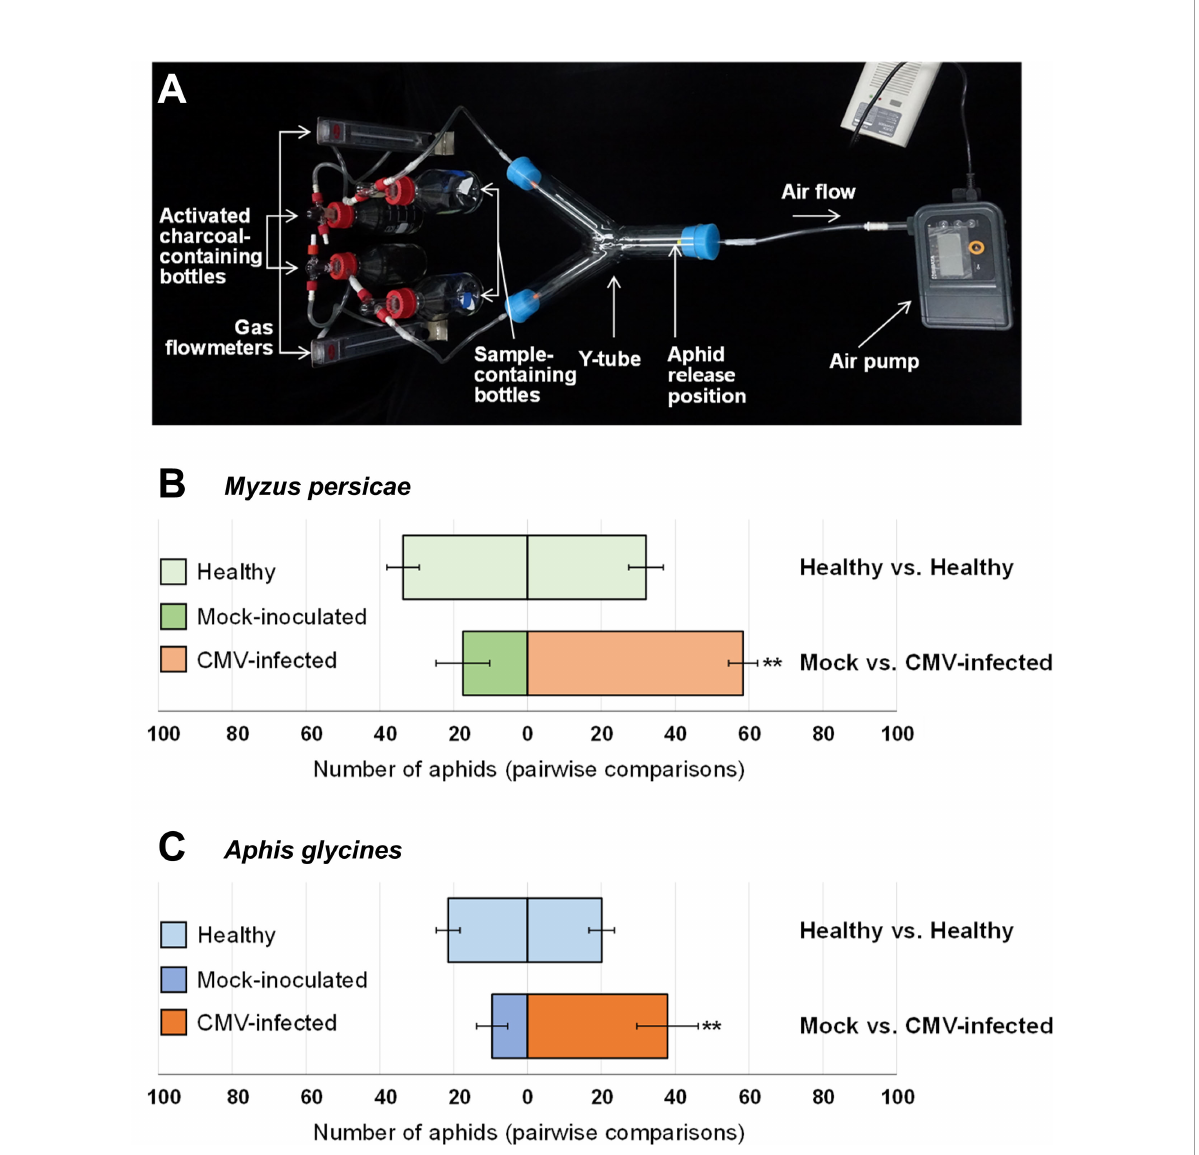
FIGURE 1 Aphid attraction to volatiles from healthy, mock-inoculated, or cucumber mosaic virus (CMV)-infected plants. (A) The glass Y-tube olfactometer used in this study for aphid preference tests. Pairwise preference tests for Myzus persicae (a species that colonizes pepper) (B) and Aphis glycines (a species that does not colonizes pepper) (C) . In pairwise aphid preference tests, pepper plants were treated as follows: healthy vs. healthy; mock- inoculated vs. CMV-infected. Pairs involved in each preference test are shown horizontally. Each pairwise test was repeated eight times, and data were averaged and are presented as the mean ± SD. Signi fi cant differences were analyzed using paired Student ’ s t -test (** P <